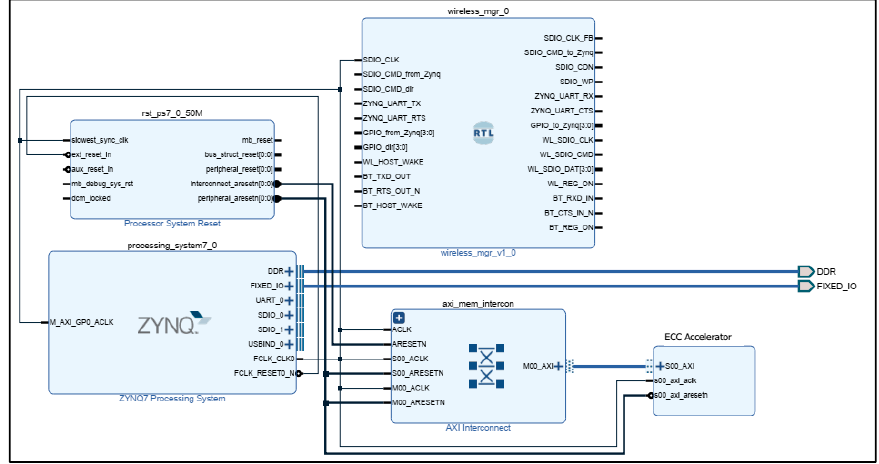
Figure 5. Hardware architecture of IoTS (IoT Server coordinator) and IoTC (IoT Client coordinator) designs.